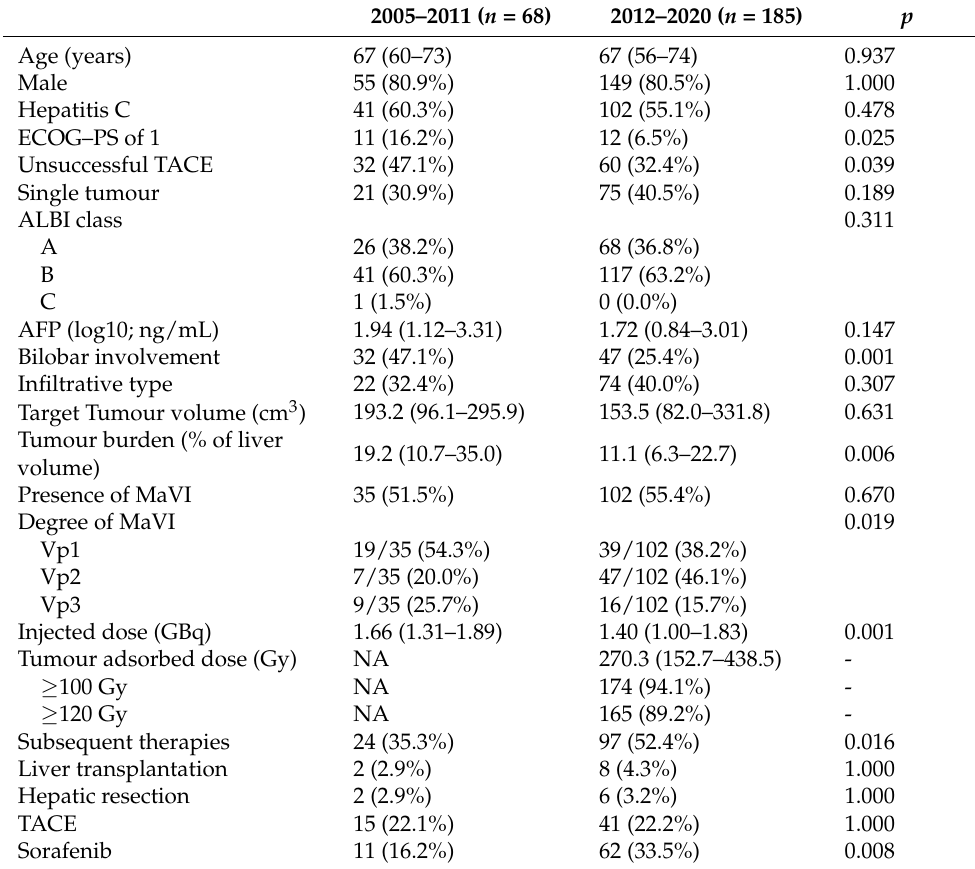
Abbreviations: TACE: transarterial chemoembolisation; ECOG-PS:Eastern Cooperative Oncology Group- Performance Status; ALBI: Albumin–Bilirubin; AFP: alpha-fetoprotein; MaVI: macroscopic (neoplastic) vascular invasion; GBq: Giga Becquerel; Gy: Gray; Vp1: portal vein